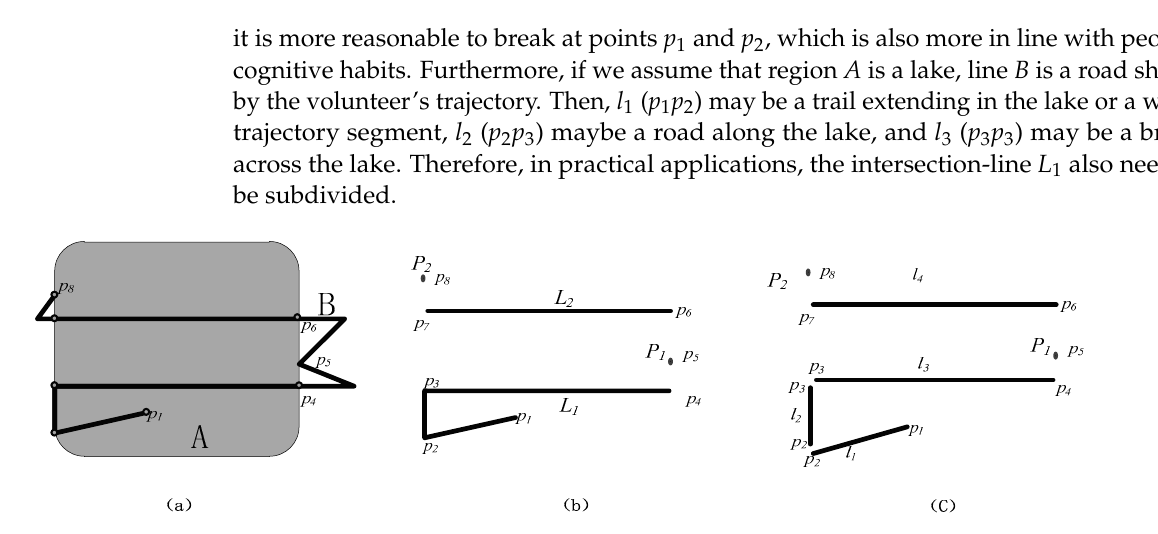
Figure 4. Example of differences between topological intersection components and spatial intersection components. ( a ) Region A and line B; ( b ) Topological components of A ∩ B; ( c ) Spatial components of A ∩ B.